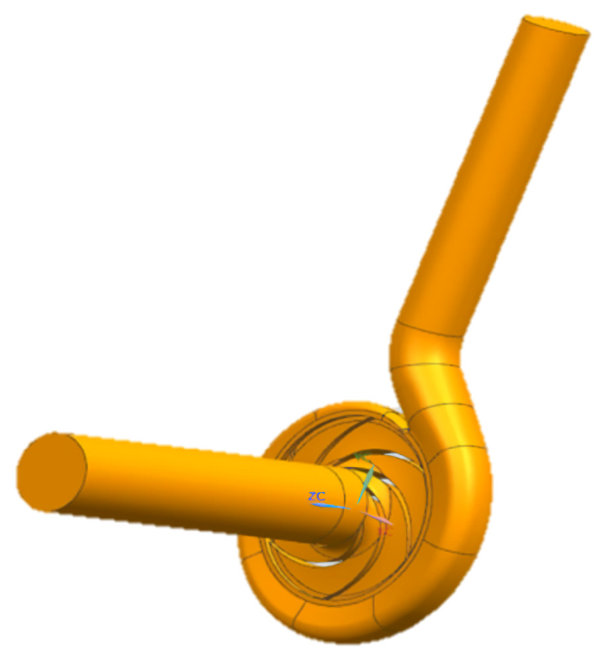
Figure 1. Three-dimensional model of the computational domain.